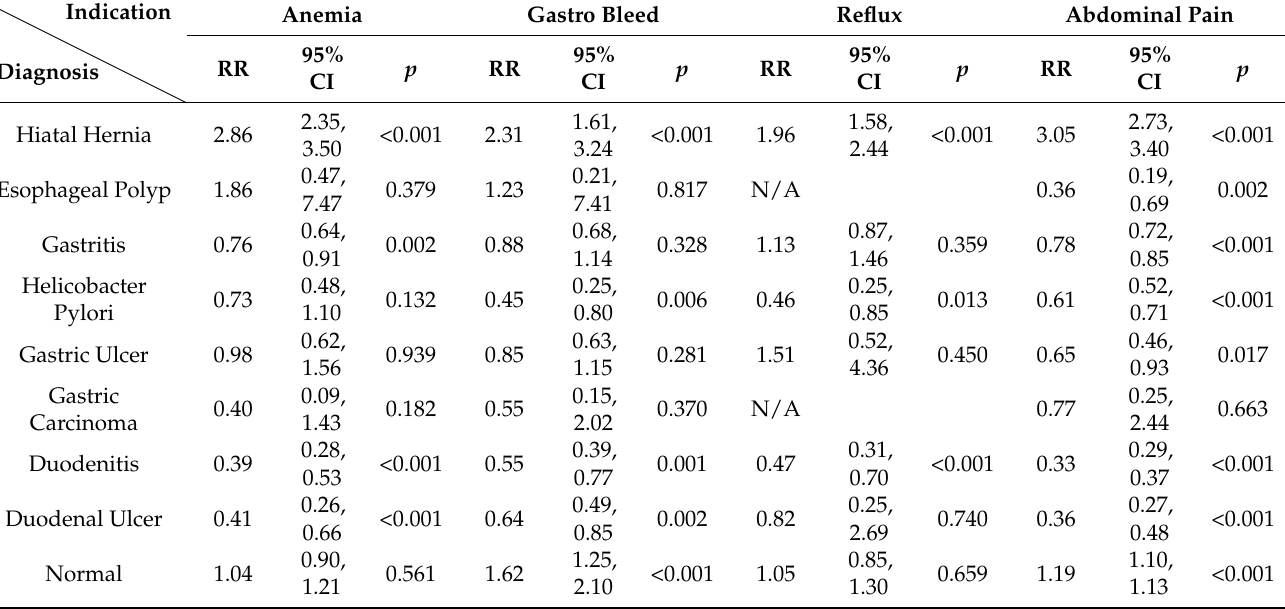
Table 6. The relative risk (for female) for findings in